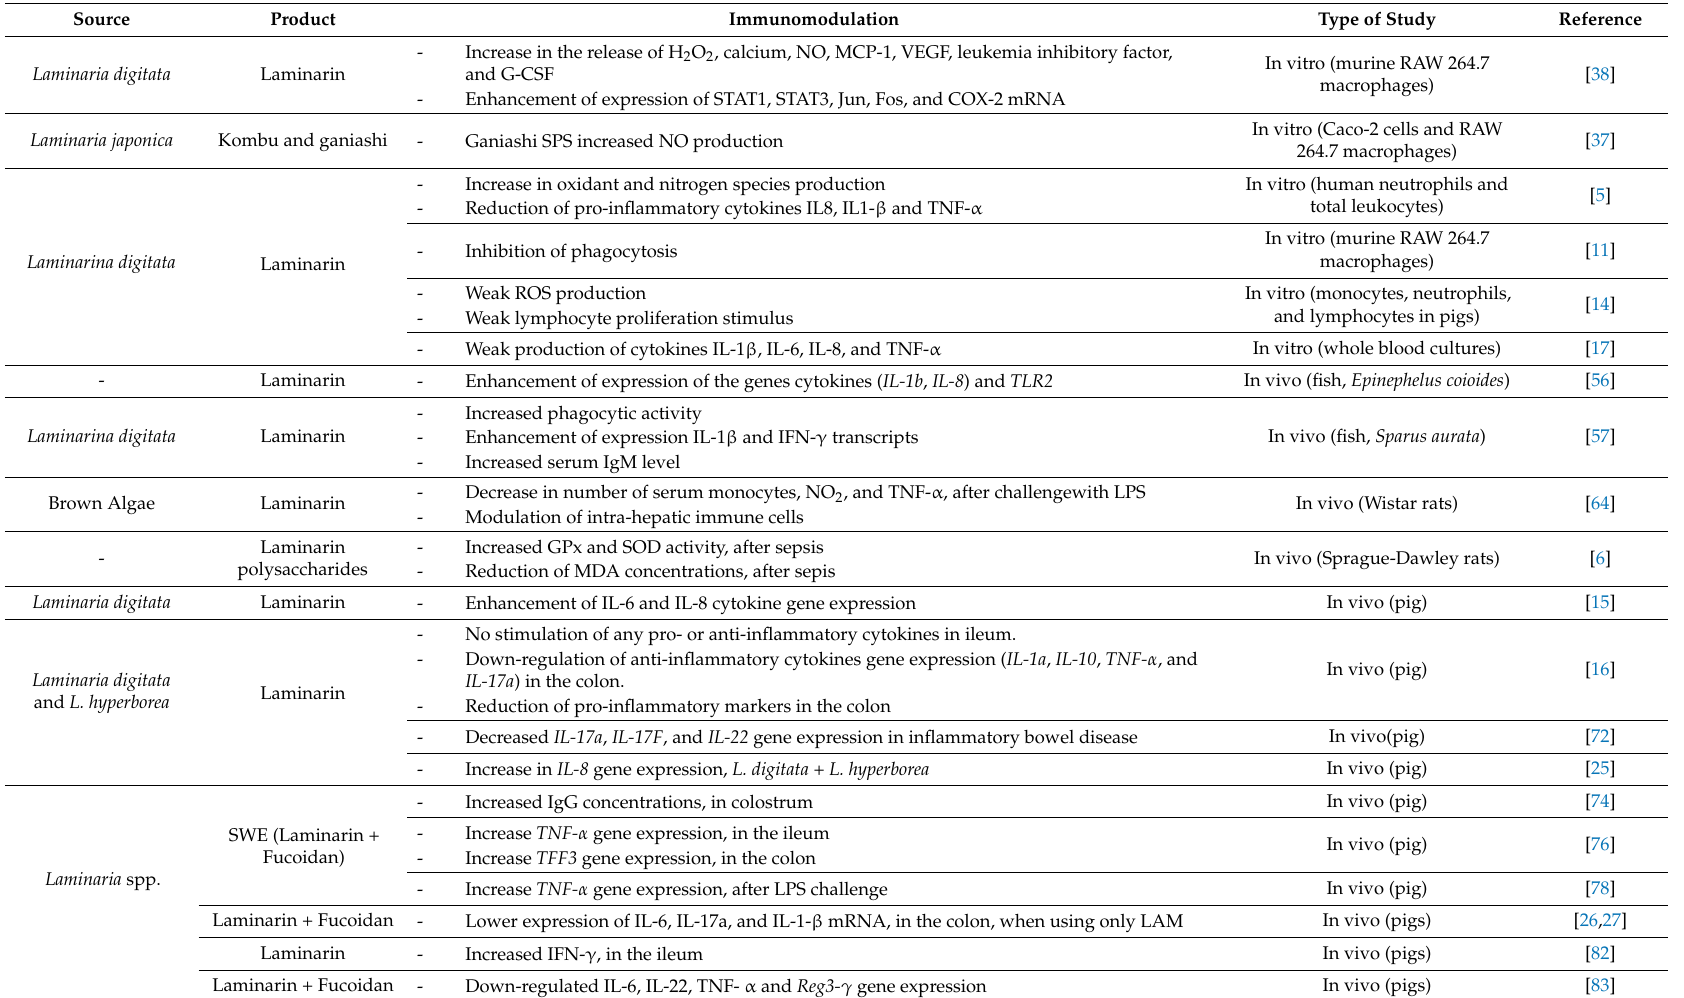
Table 1. Immunomodulatory properties of β -glucans from genus Laminaria